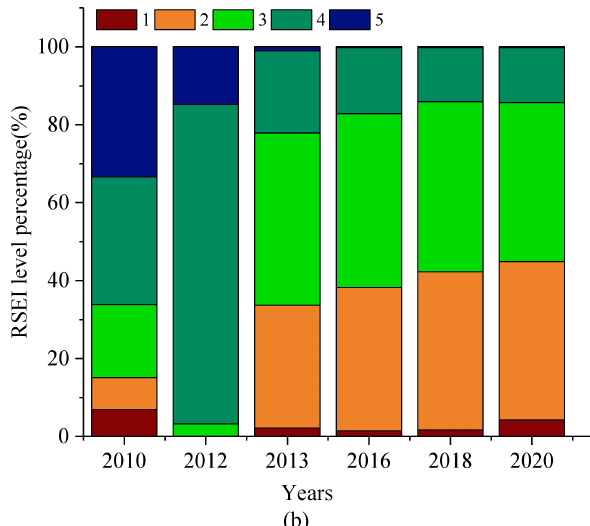
Fig.3. RSEI Data Box diagram and Grade Area percentage in 2010, 2012, 2013, 2016, 2018, 2020. ( a ) RSEI Data Box diagram, ( b ) Grade area percentage. The legend of Fig.3b is Grade 1: 0-0.2; Grade 2: 0.2-0.4; Grade 3: 0.4-0.6; Grade 4: 0.6-0.8; Grade 5: 0.8-1.